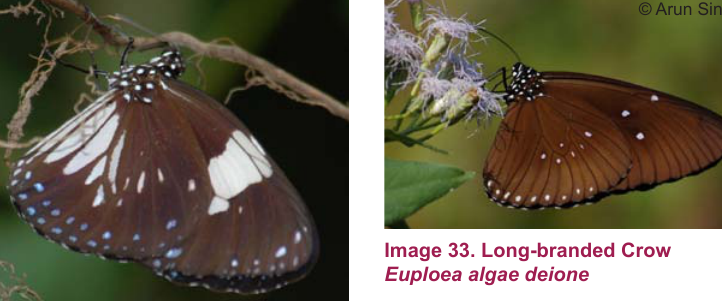
Image 33. Long-branded Crow Euploea algae deione